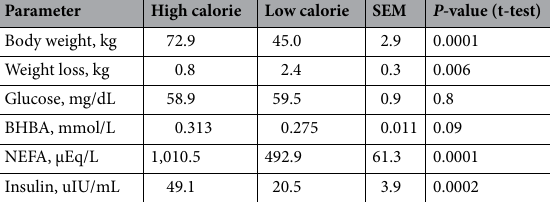
Parameter High calorie Low calorie SEM P- value (t-test) Body weight,